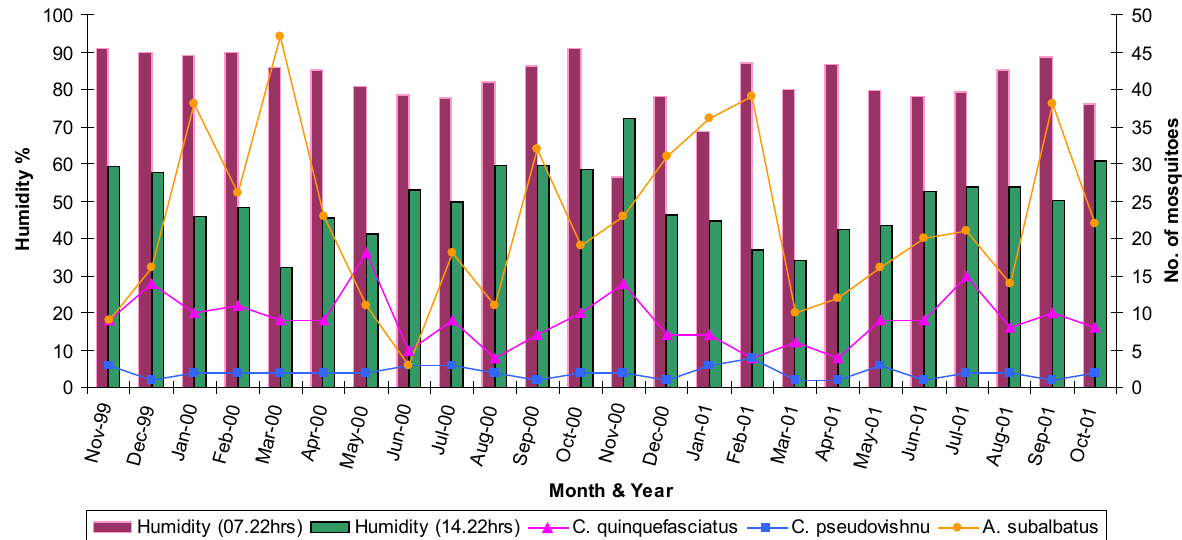
Figure 7. Population dynamics of mosquito species in relation to temperature (maximum and minimum ) in Kavundampalayam POPULATION DYNAMICS OF MOSQUITO SPECIES IN RELATION TO TE